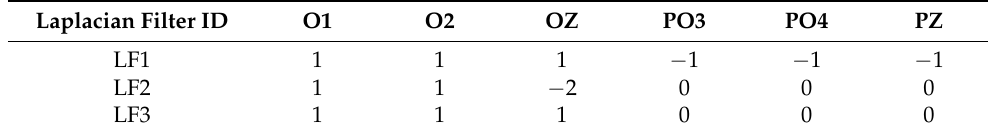
Table 6. Laplacian filter weights.